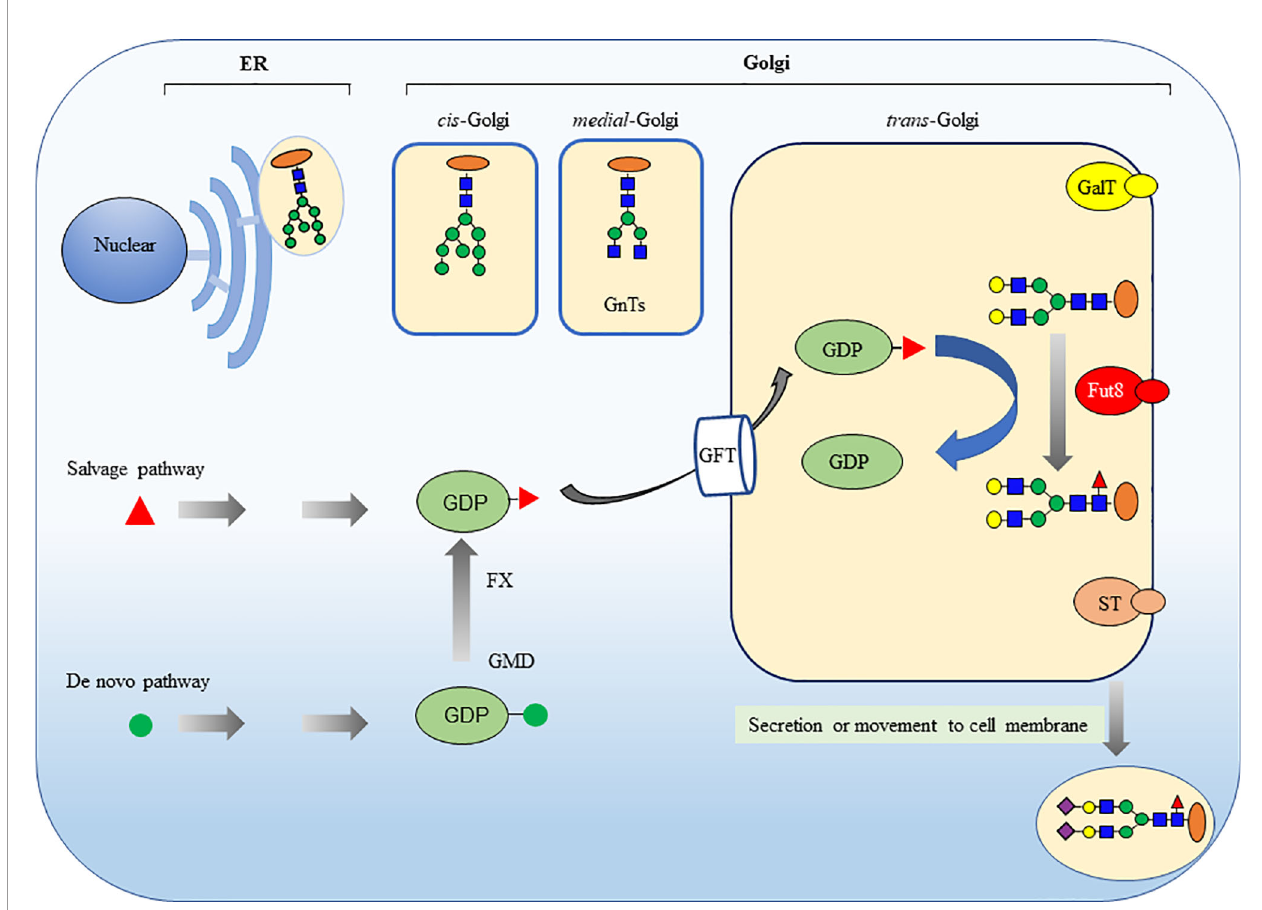
FIGURE 2 | Core fucosylation modi fi cation in mammalian N-glycans is catalyzed by FUT8. The ER-Golgi pathway harbors many glycan-modifying enzymes in eukaryotic cells. The glycosyltransferases that operate in the ER are woven into the ER membrane. In contrast, the glycosyltransferases in Golgi compartments are generally type II membrane proteins with a small cytoplasmic amino-terminal domain, a single transmembrane domain, and a large lumenal domain that has an elongated stem region and a globular catalytic domain. FUT8 is a typical type II membrane protein and a Golgi apparatus – resident glycosyltransferase to catalyze the transfer of a fucose from GDP-fucose to the inner GlcNAc of N-glycans through a 1,6-linkage (core fucosylation). There are two different pathways for producing GDP-fucose, namely salvage pathway and de novo pathway. The GDP-fucose is transferred from the cytosol into the Golgi apparatus by GDP-fucose transporter (GFT). The sugar additions, such as galactosylation by GalT, fucosylation by FUTs and sialylation by STs, mostly occurring in the trans